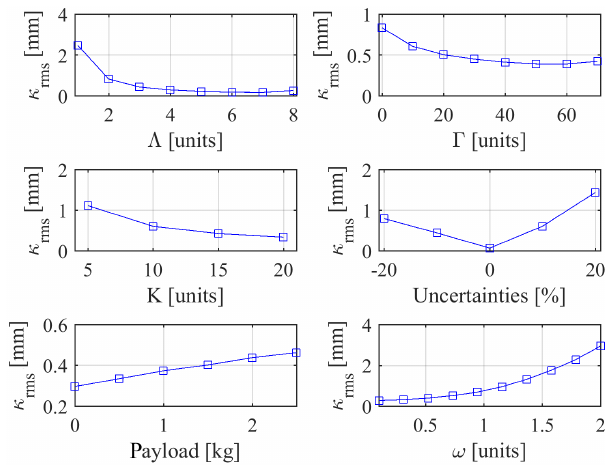
Figure 9. Controller parameter sensitivity and robustness analysis results: Parameter variations vs. Root-mean-square error of end- effector